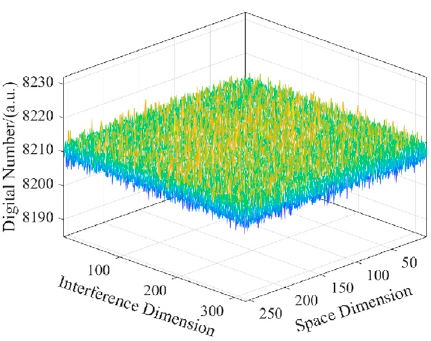
Figure 9. The intensity distribution of image plane of point light source imaging by the beam ex- pander system.